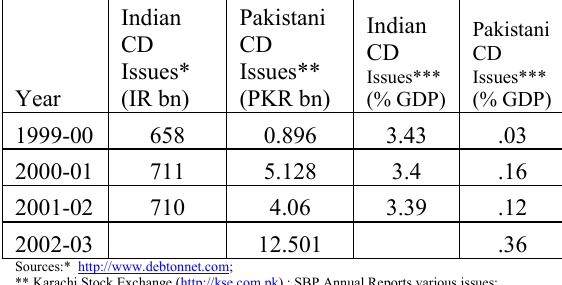
Table 1. Growth of Corporate Debt Markets in South